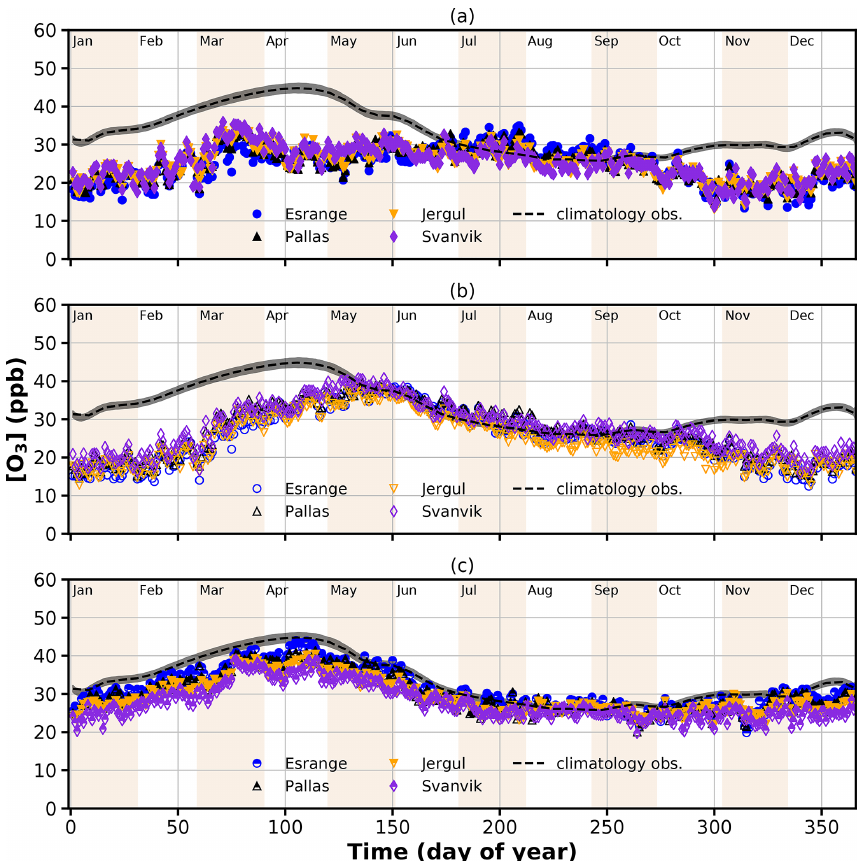
Figure 3. Daily mean ozone climatologies computed from the ozone reanalysis products (a) MACC, (b) CAMSRA, and (c) CAMSRAQ ensemble mean. The reanalysis products were evaluated at the nearest-neighbor grid point of the featured monitoring sites to assess also the vertical resolution. The generalized ozone climatology, shown as a gray band, represents the expected seasonal cycle of ground-level ozone background O 3 in northern Fennoscandia. On average, all reanalysis products underestimate [ O 3 ] .